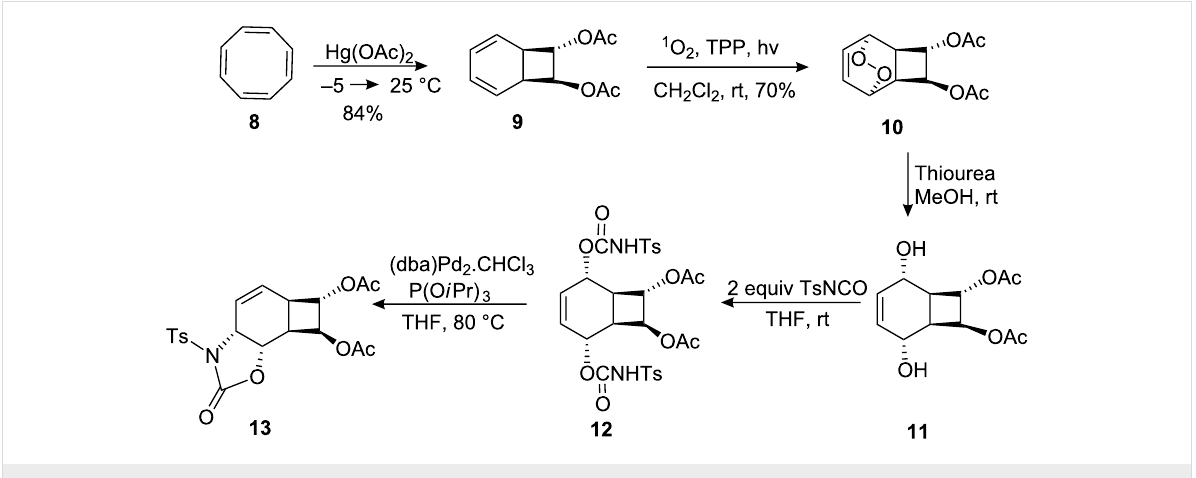
Scheme 1: Synthesis of bis-carbamate 12 and oxazolidinone 13